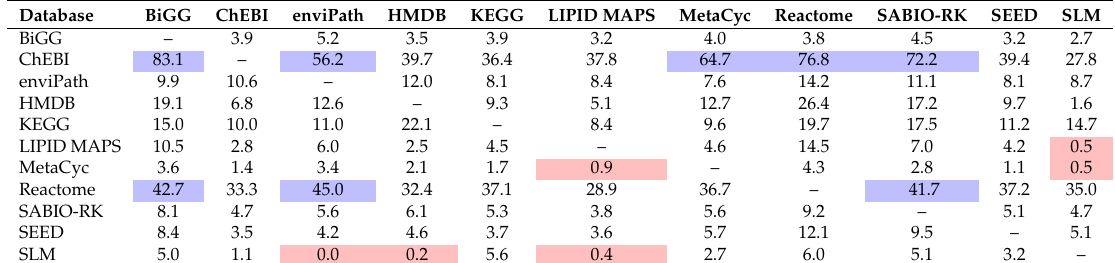
Figure 4. Visualization of the inter database inconsistency. An ID from BiGG (in yellow) can link to many other IDs in CheBI (red) when using MetaNetX ID (green) for the mapping. Table 8. Percentage of IDs in the database in the column that get mapped to more than one ID in the database in the corresponding row using database MetaNetX as a bridge. Blue boxes are used to highlight highest numbers. While red boxes indicate lowest numbers.